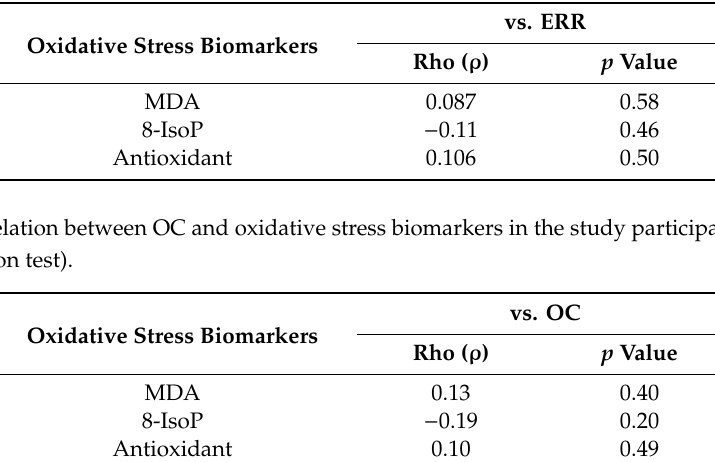
Table 8. Correlation between ERR and oxidative stress biomarkersin the study participants (Spearman rank correlation test).